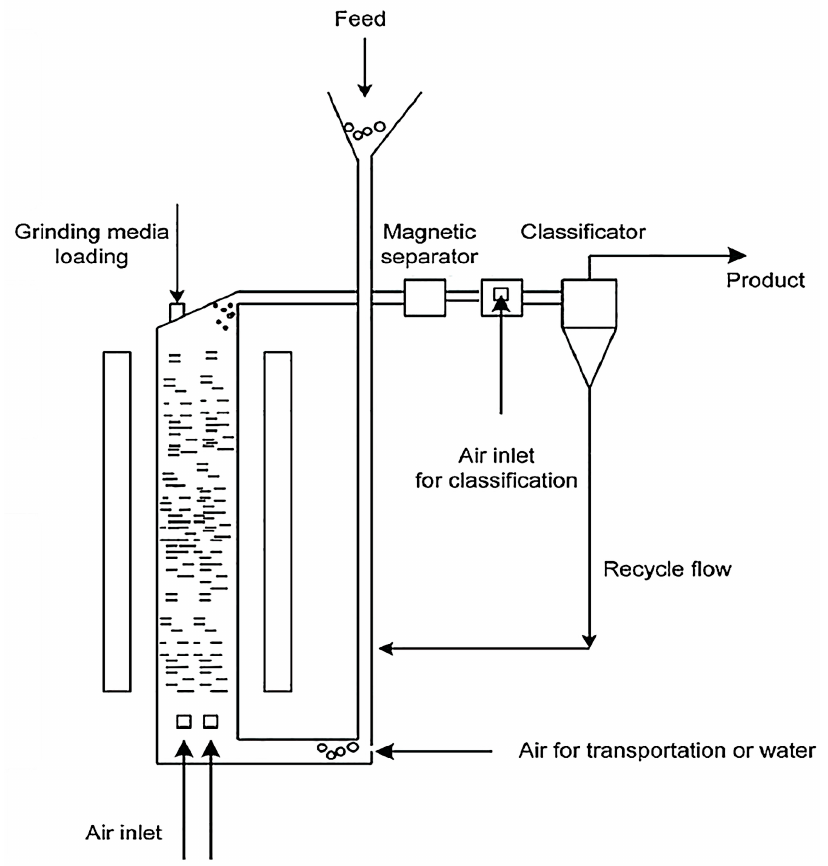
Figure 2. Grinding and classification simplified diagram in the electromagnetic mill.